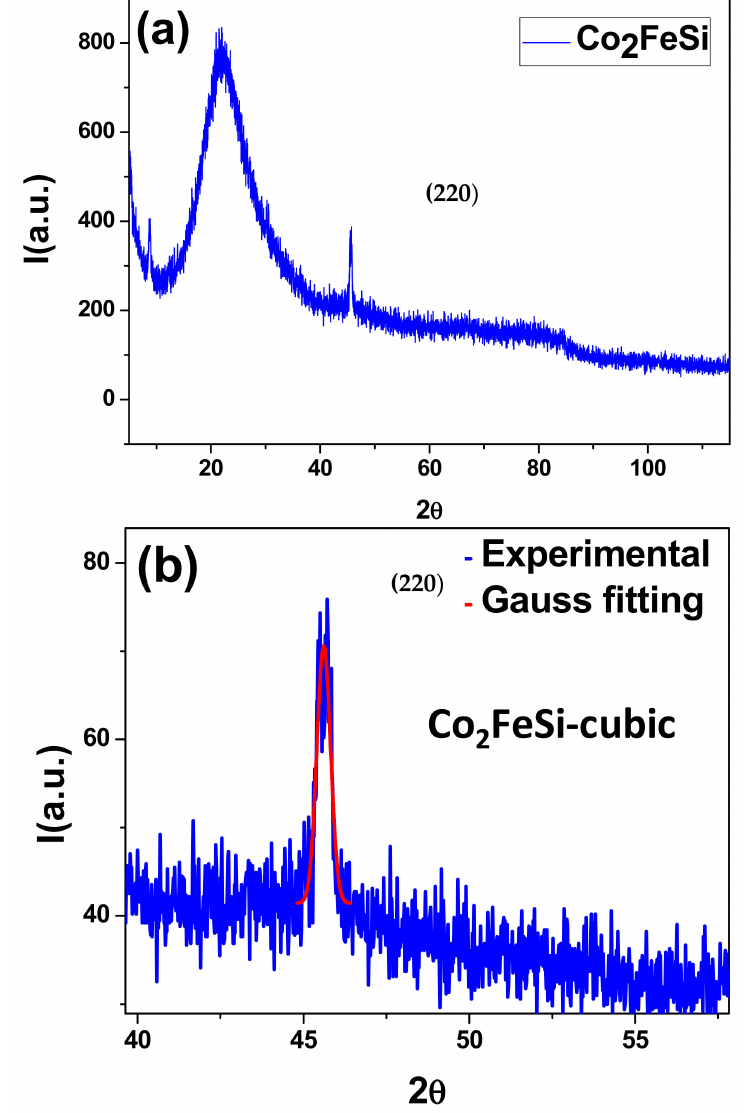
Figure 2. X-ray diffraction pattern of Co 2 FeSi G-CMMWs ( a ) and focusing on the crystalline part of Co 2 FeSi G-CMMWs with a Gauss fitting ( b